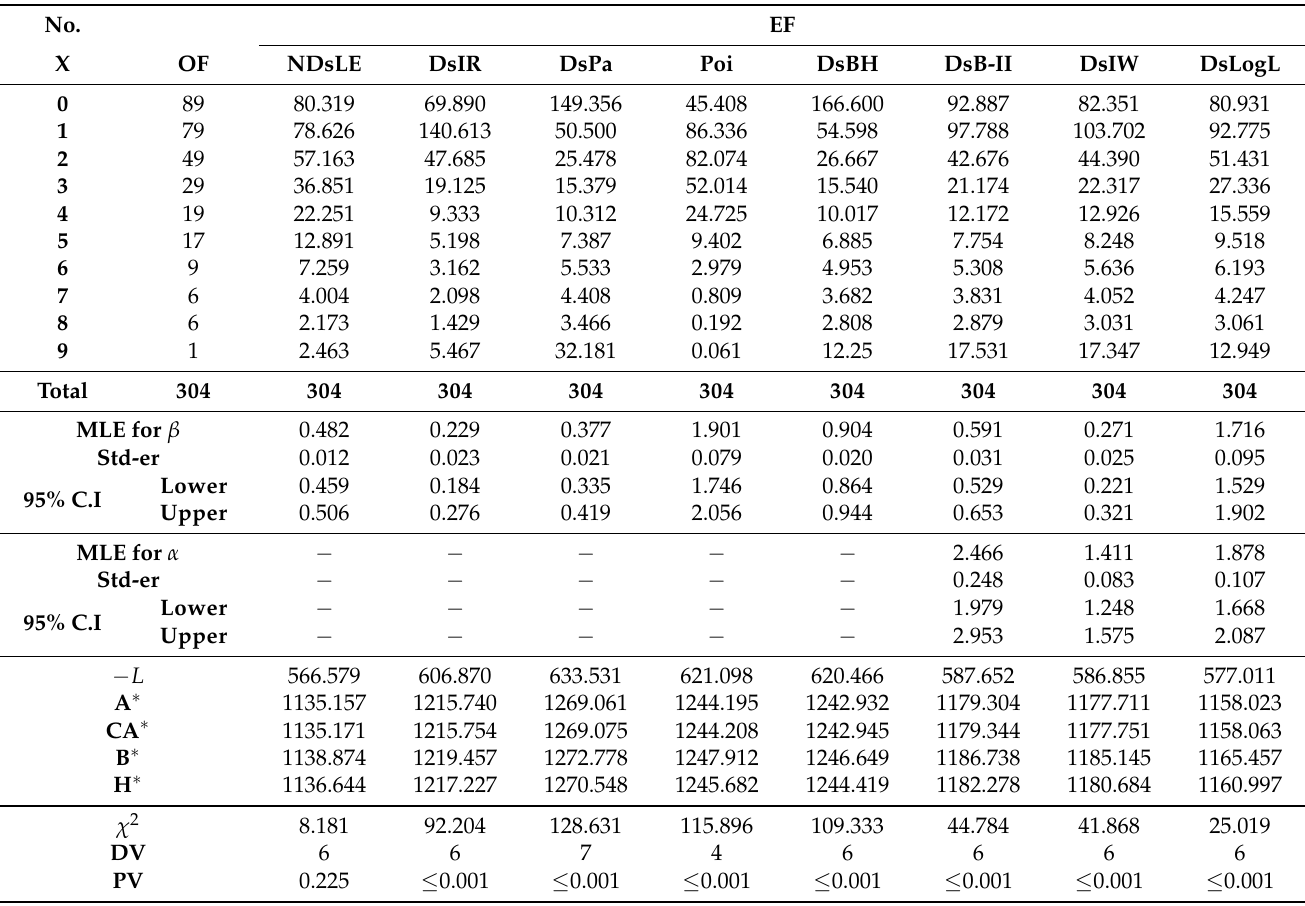
Table 12. The MLEs, Std-er, C.I, and GOF measures for data set III.